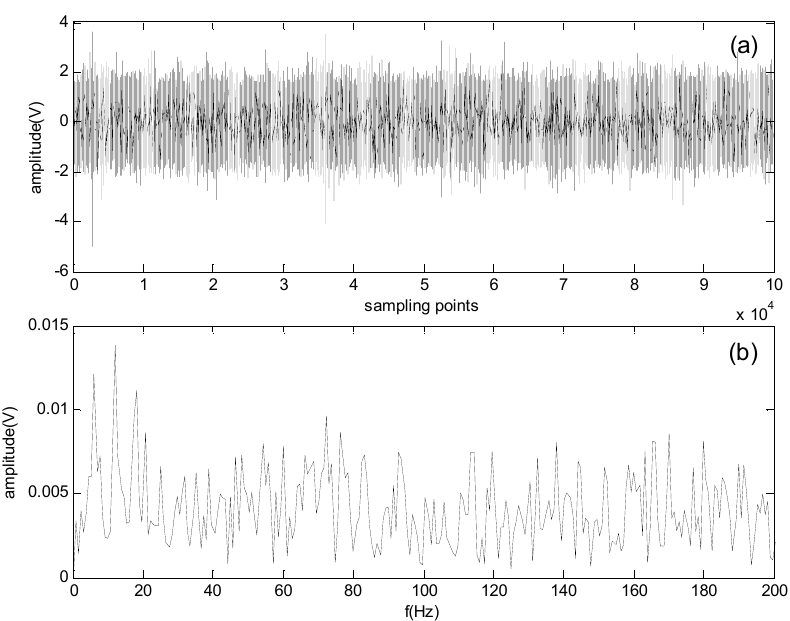
Figure 13. Noisy signal and its spectrum: ( a ) Waveform of the noisy signal; ( b ) Spectrum of the noisy signal.